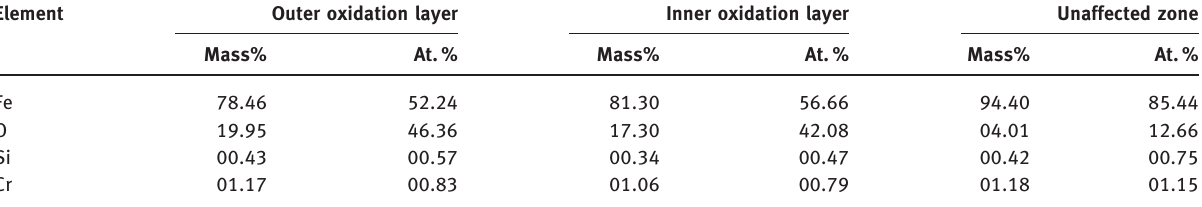
Table 7: Composition of cross-sectional layers on the bare specimen (998.15K/100MPa). Element Outer oxidation layer Inner oxidation layer